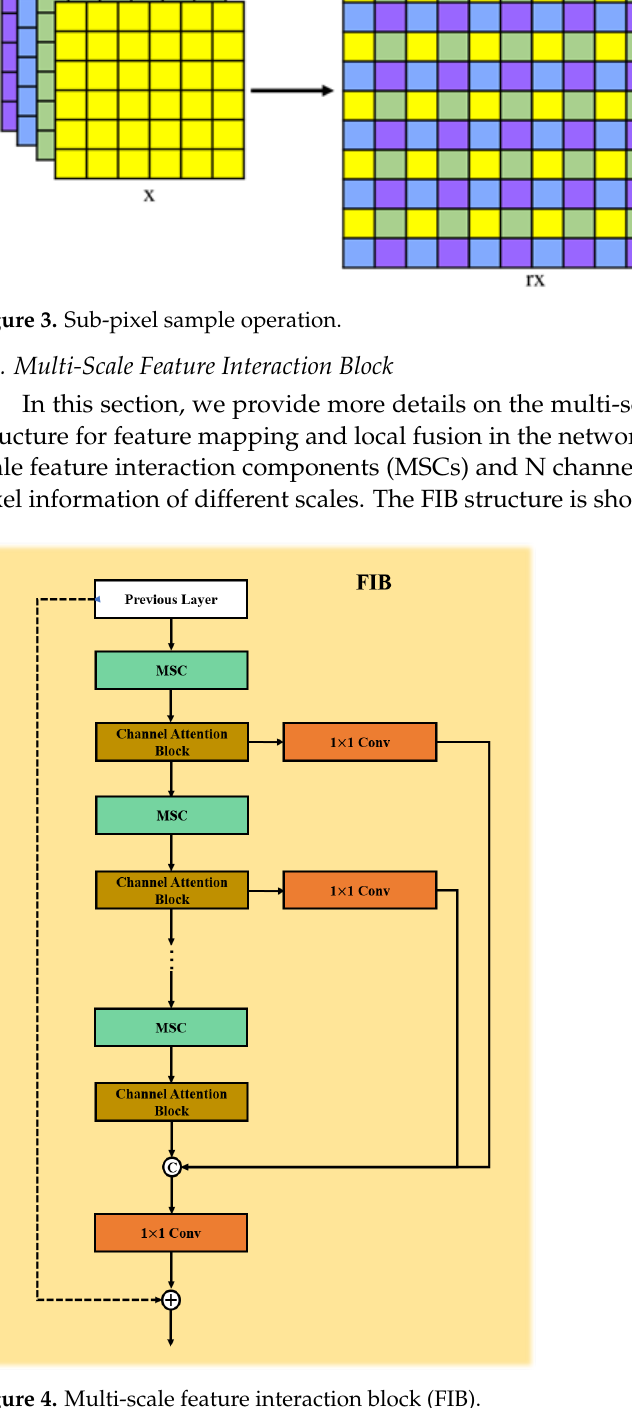
Figure 4. Multi-scale feature interaction block